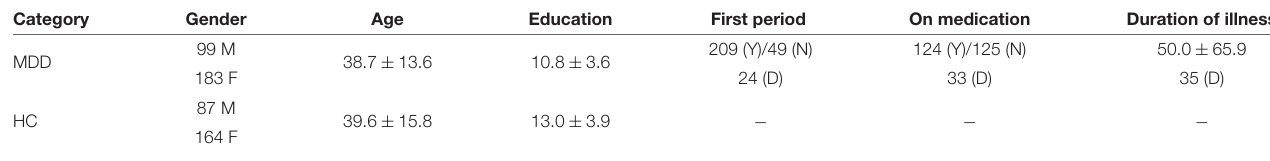
TABLE 1 | Demographic and clinical information of subjects from Southwest University [a part of the REST-meta-MDD consortium (Yan et al., 2019)]. Category